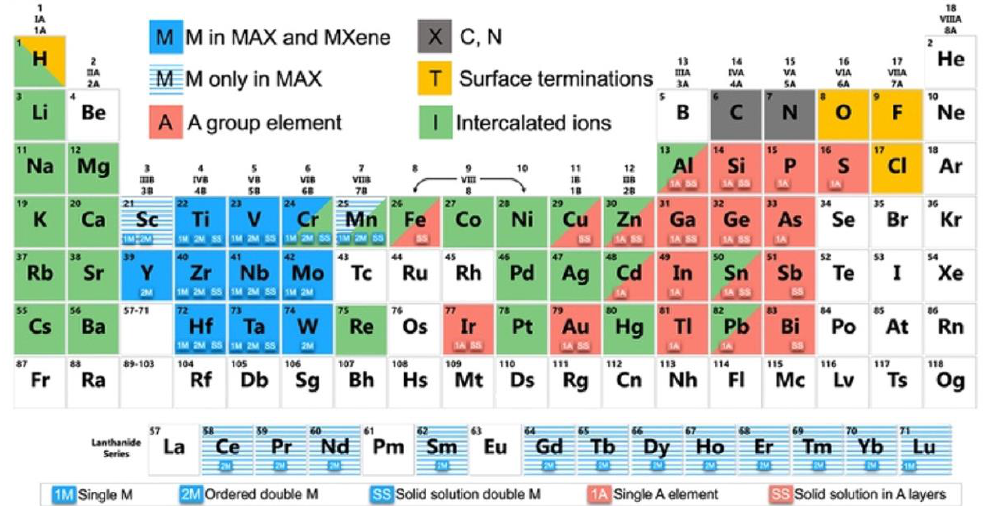
Figure 1. Elements used to build MAX phases, MXenes, and their intercalated ions. Adapted with permission [9]. Copyright 2019, American Chemical Society.